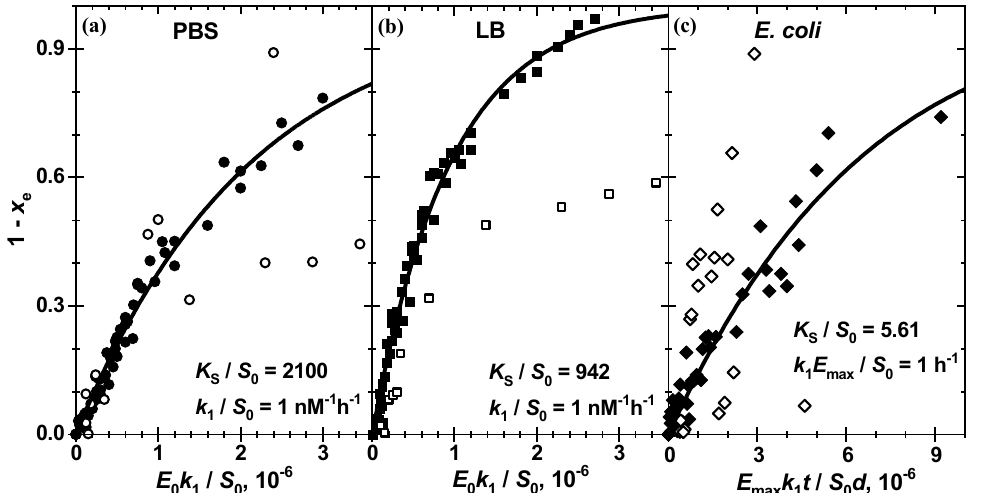
Table 1, the latter is assumed to be equal to 1 nM − 1 h − 1 .